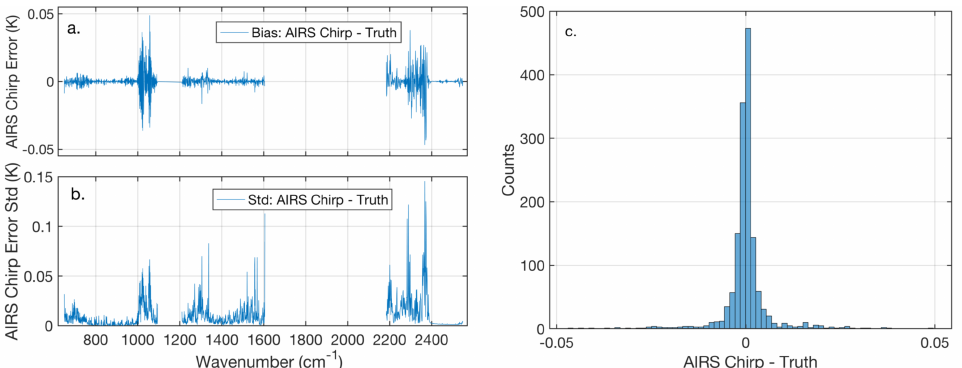
Figure 4. Accuracy of the CHIRP translation from AIRS using 49 highly variable test radiances. Truth is defined as the AIRS radiance computed from a line-by-line monochromatic radiance spectrum. Bias error in shown in ( a ), the standard deviation over the 49 profiles in ( b ), and ( a ) histogram of the bias errors in ( a ). are shown in ( c ). clearly showing that most bias errors are below 0.01